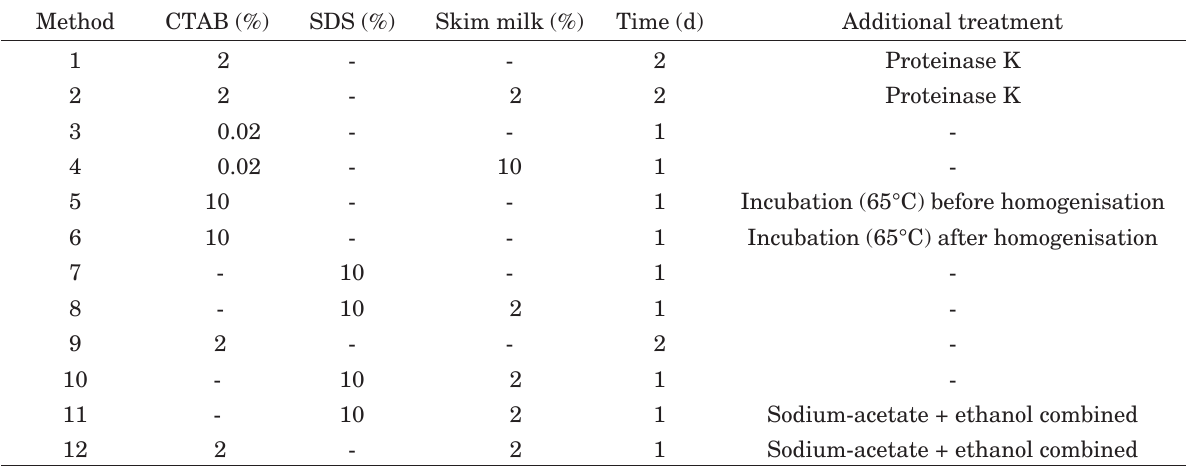
Table 3. Differences between the DNA-extraction protocols tested. Varied concentrations (w/v) of CTAB, SDS and skim milk used in extraction buffers are